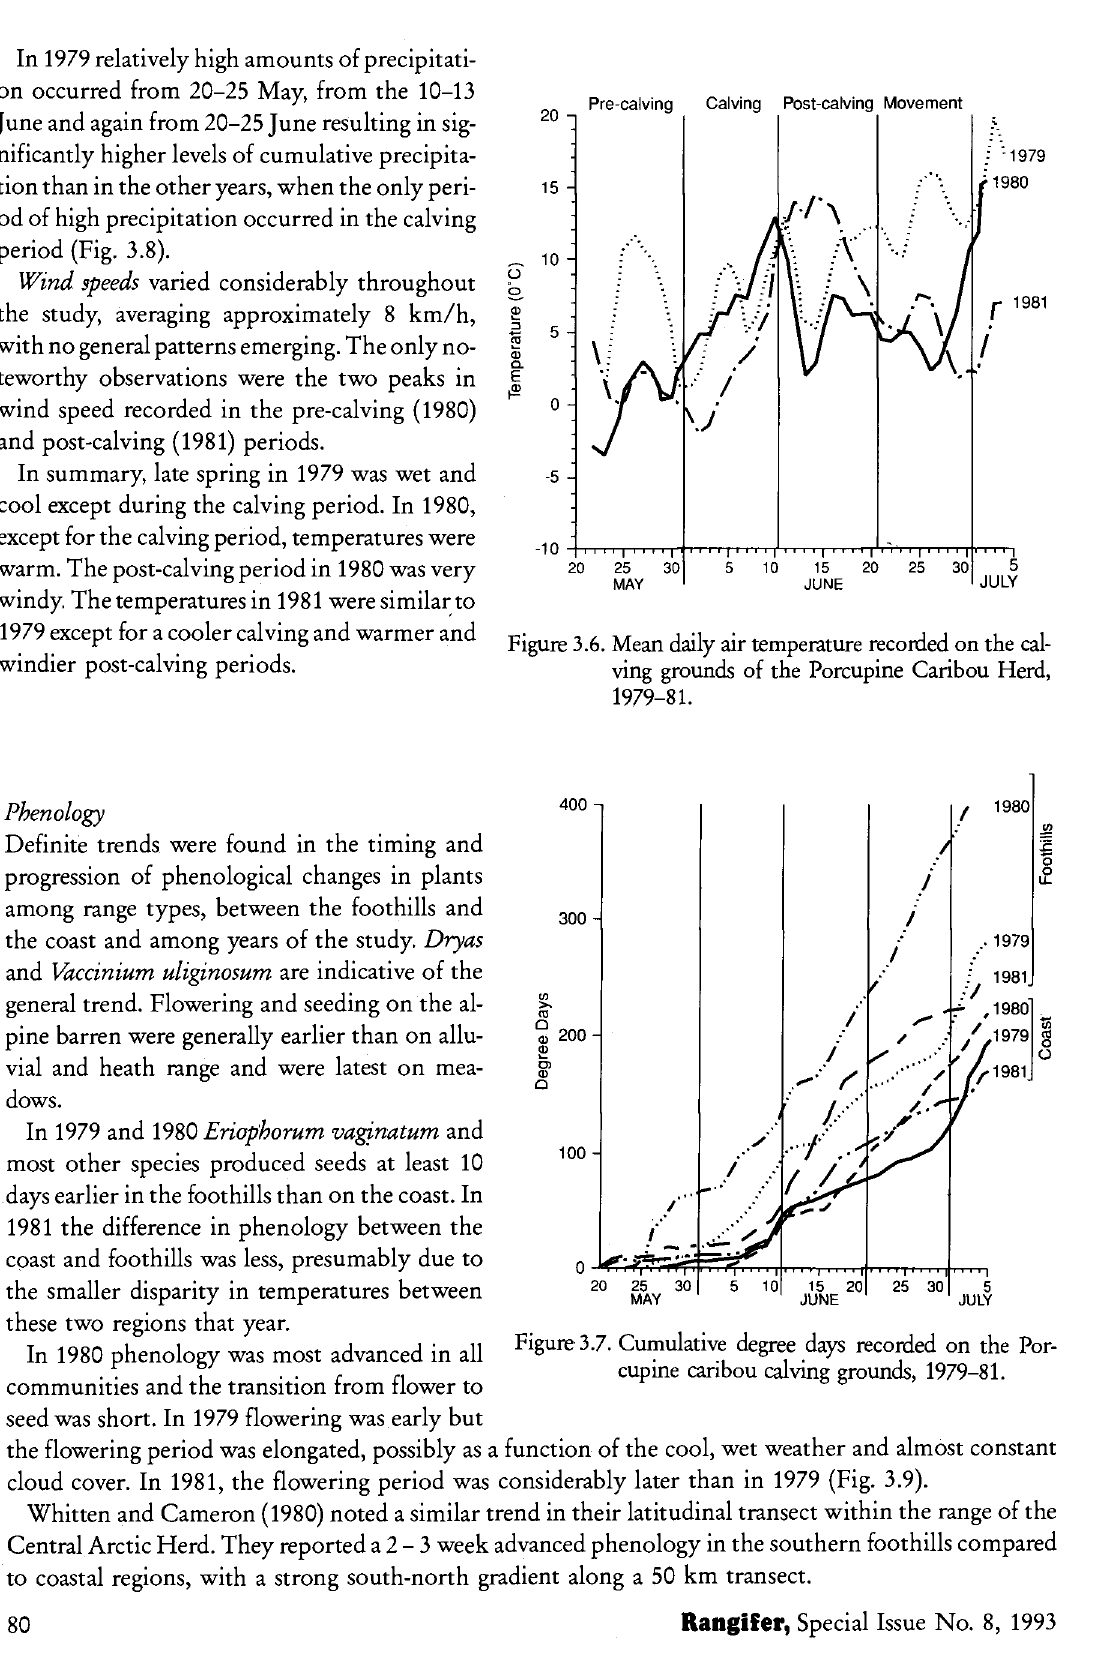
Figure 3.6. Mean daily air temperature recorded on the cal ving grounds of the Porcupine Caribou Herd, 1979-81.